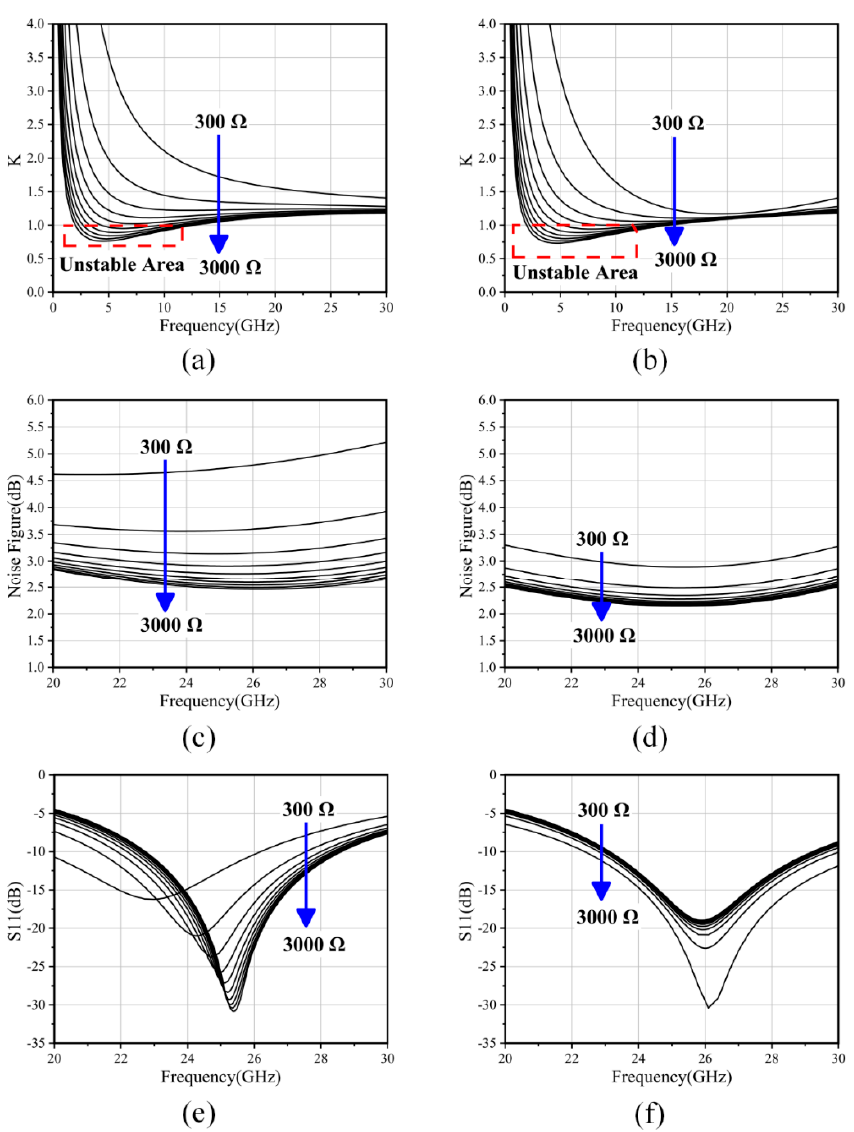
Figure 4. ( a ) Simulated K factor with resistor bias circuit postposition after Lin; ( b ) simulated K factor with resistor bias circuit proposition before Lin; ( c ) simulated noise figure with resistor bias circuit postposition after Lin; ( d ) simulated noise figure with resistor bias circuit proposition before Lin; ( e ) simulated S11 with resistor bias circuit postposition after Lin; ( f ) simulated S11 with resistor bias circuit proposition before Lin.